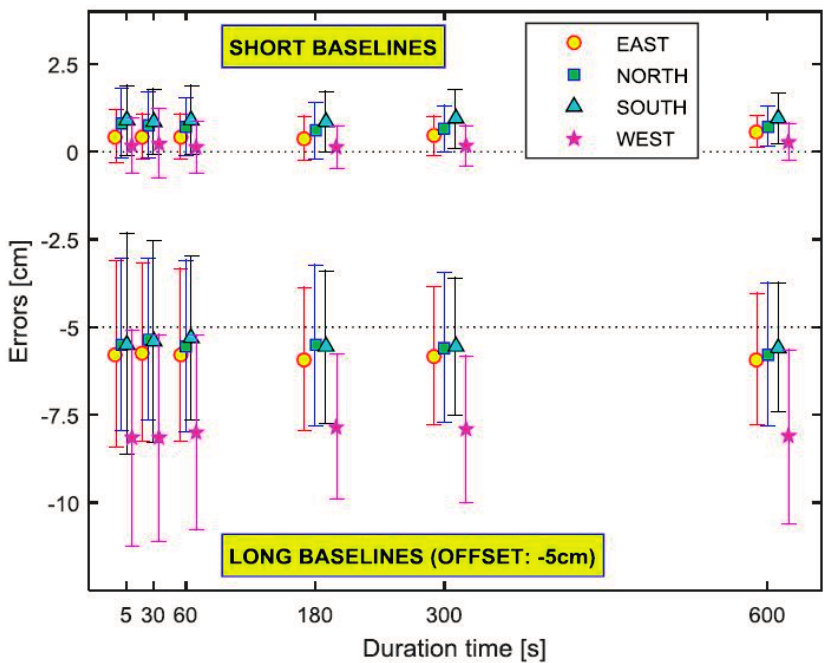
Figure 10. Estimated error bar plot of RTK by duration time and site. The long baselines are intentionally offset by 5 cm for clarity.